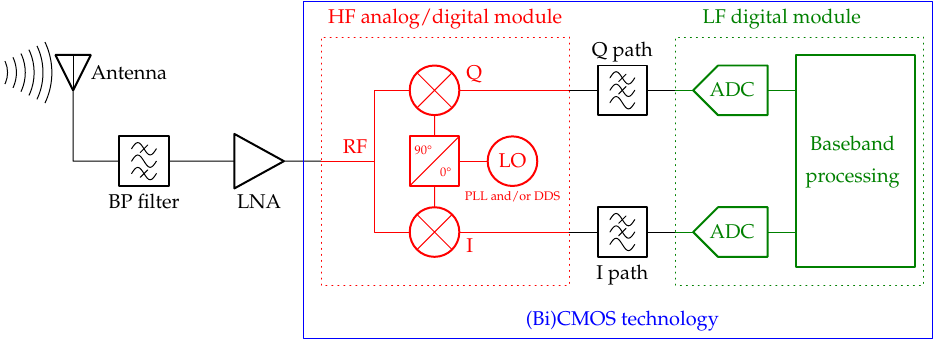
Figure 1. Zero-IF receiver architecture, comprising the analog and digital part which can be integrated on the same (Bi)CMOS chip for high purity frequency signal